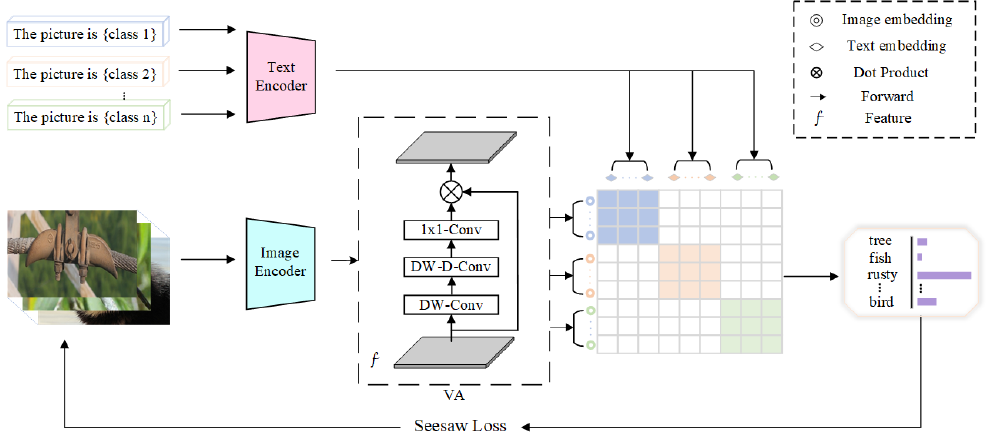
Figure 1. Overview of our TIN template. We transmitted the original image and label templates to the vision-language backbone of the long-tailed data. Visual attention was used to assess long-distance dependencies, and the relevance of each channel was determined and reweighted to improve the visual features. The gradients were reweighted according to the label frequencies when the head class obtained several gradients. Finally, the accuracy of the tail class considerably improved while the accuracy of the head class slightly